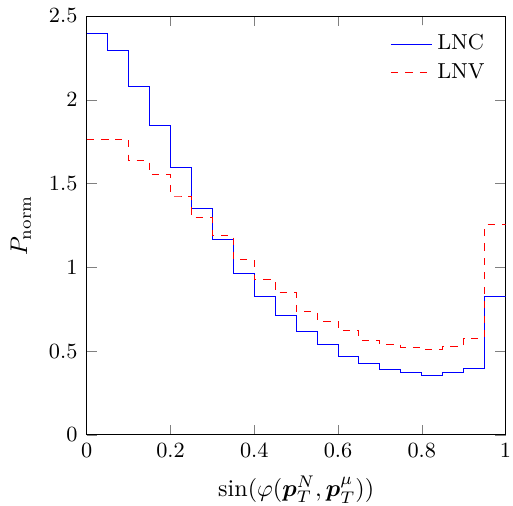
Figure 17 . Comparison between the angular dependence of the LNC process compared to the LNV process in the observable ( 6 . 5 ) using a MC